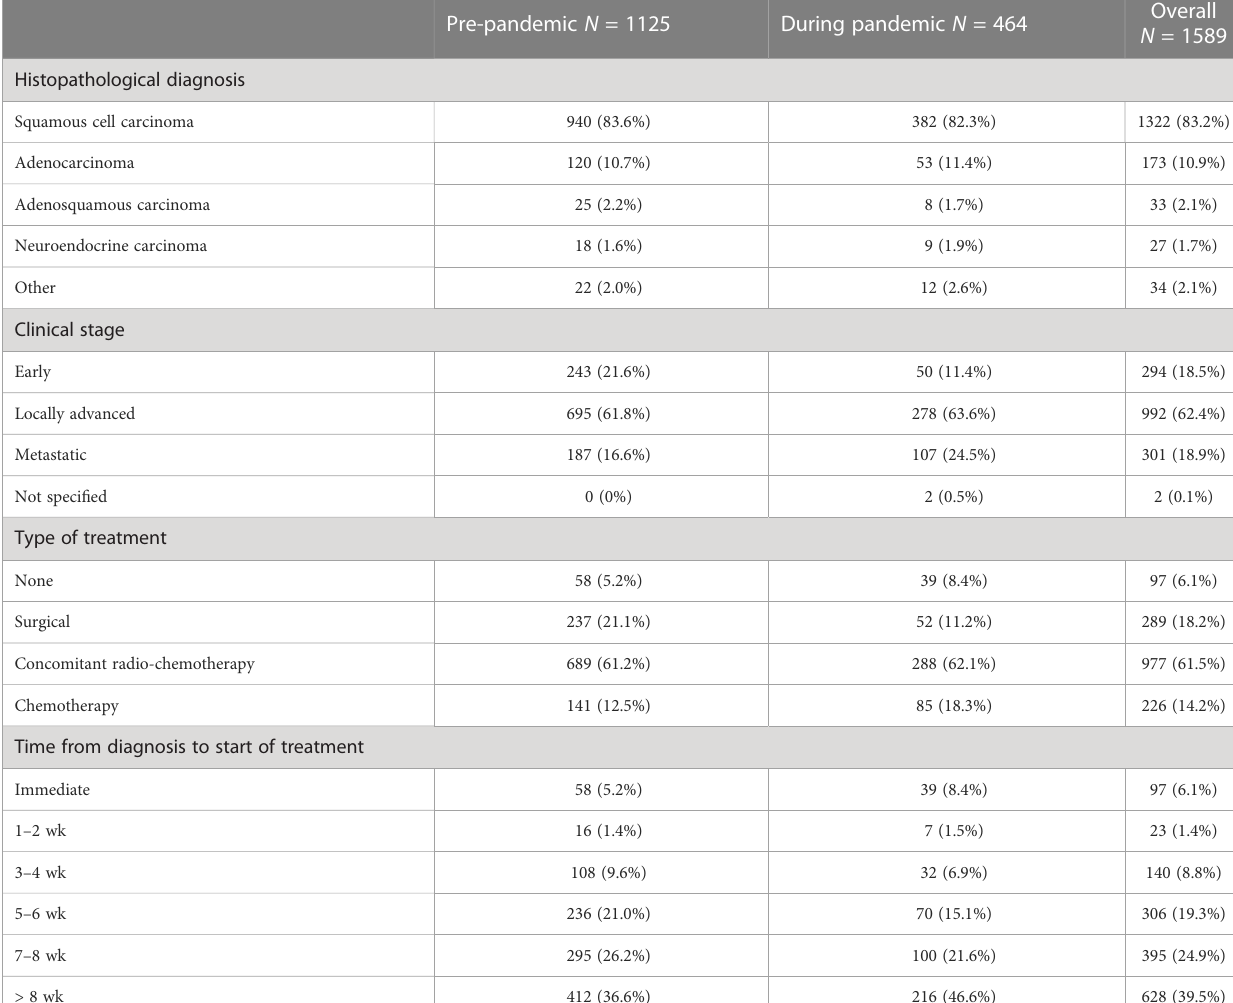
TABLE 3 Indicators of the tertiary prevention level from INCAN